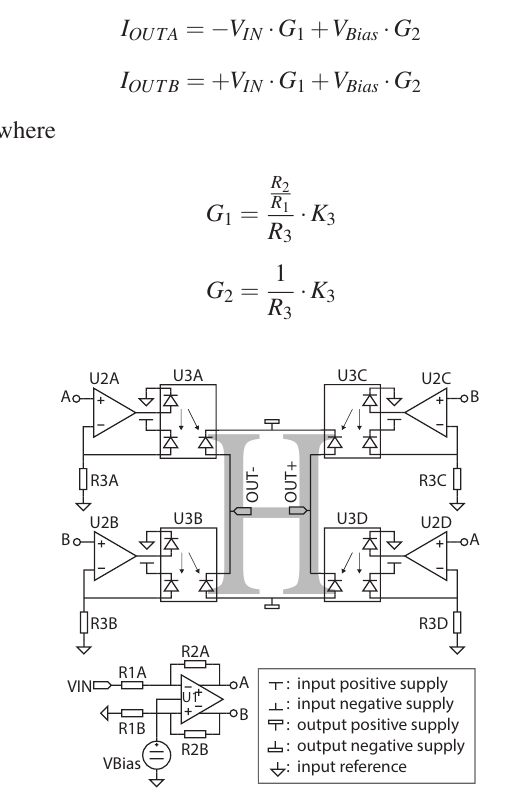
Fig. 2: The isolated H-bridge. The outputs A and B of the opamp- circuit at the bottom are the same nodes as A and B on the U 2 x opamp